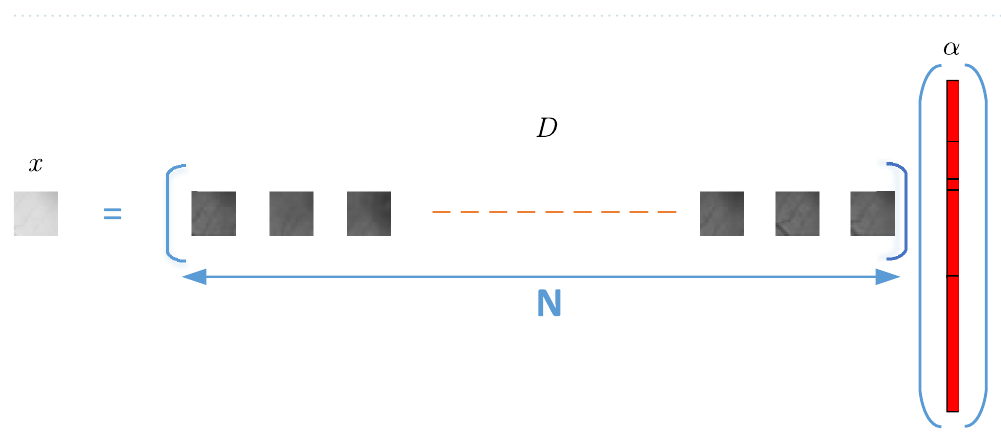
Figure 1. Serial expansion by linear interpolation.